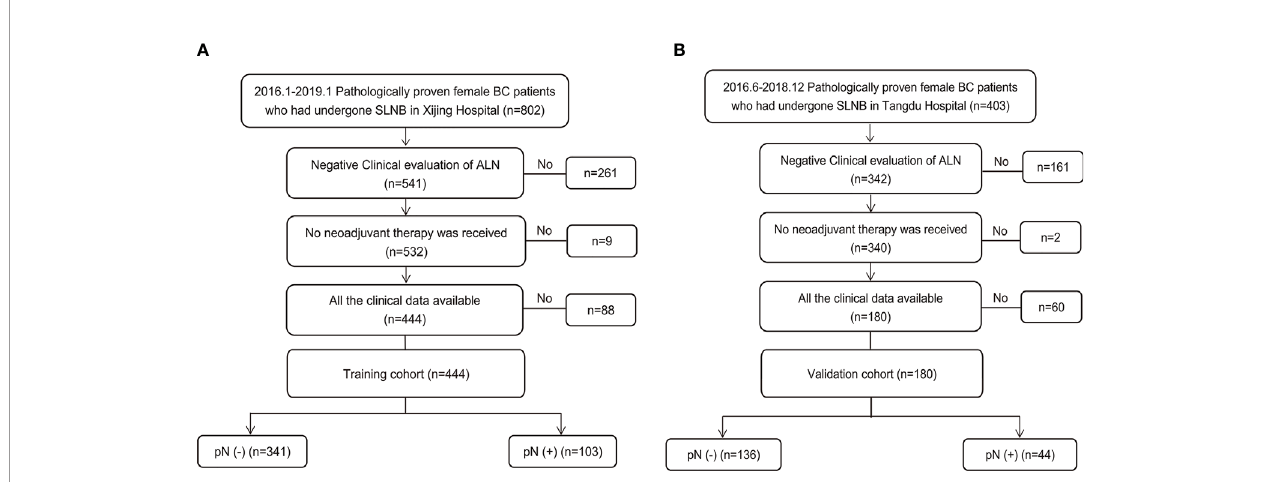
FIGURE 1 | Study population enrolment in the training and validation cohort. (A) Study population enrolment in the training cohort; (B) Study population enrolment in the validation cohort. SLNB, sentinel lymph node biopsy; BC, breast cancer; pN(-), negative lymph node metastasis con fi rmed by pathology; pN(+), positive lymph node metastasis con fi rmed by